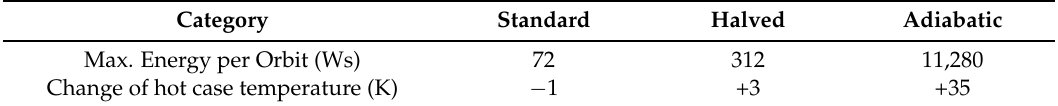
Table 1. Main results of the thermal analysis of Sentinel-2 solar panel in different thermal